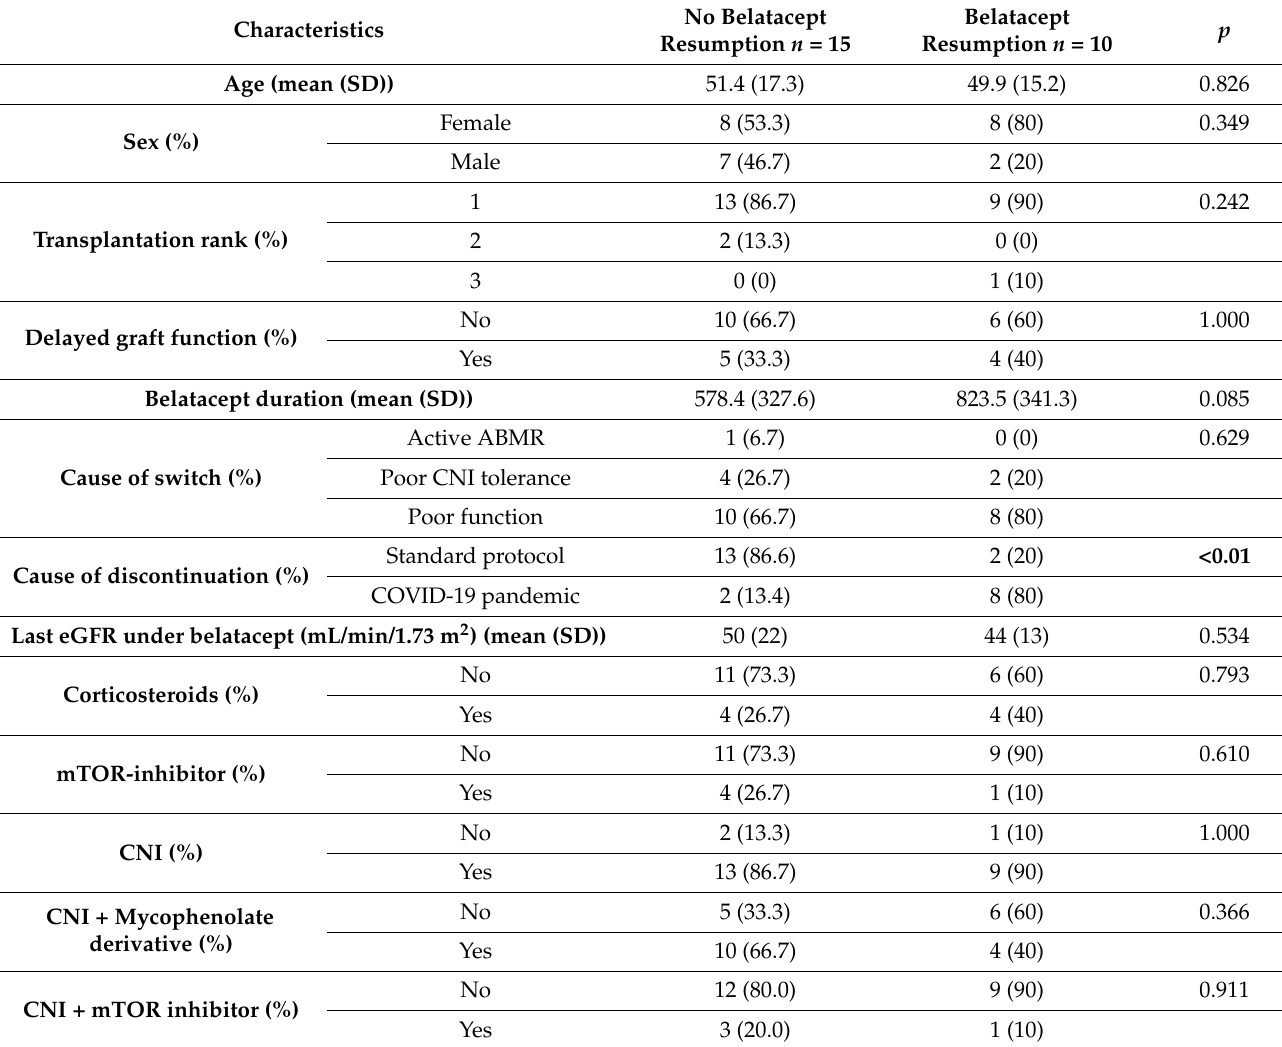
Table 2. Patient’s characteristics according to their belatacept resumption